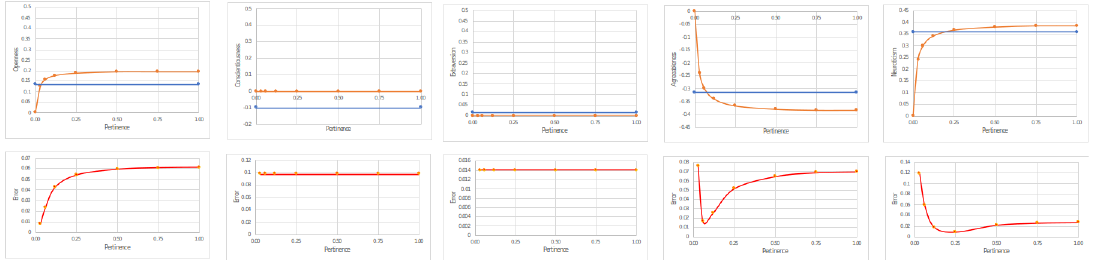
Figure 11. Error graphics from Disliking input emotion—OCEANS’s factors.